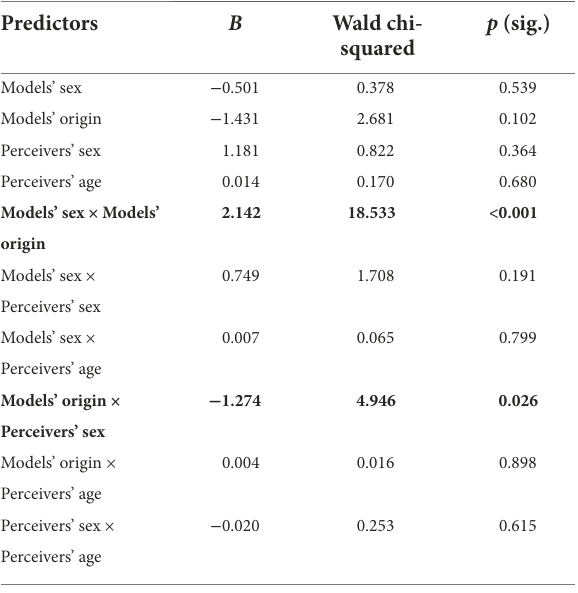
TABLE 1 Effects of models’ sex and origin, and sex and age of perceivers on ability to guess anger. Dependent var.: Guess anger